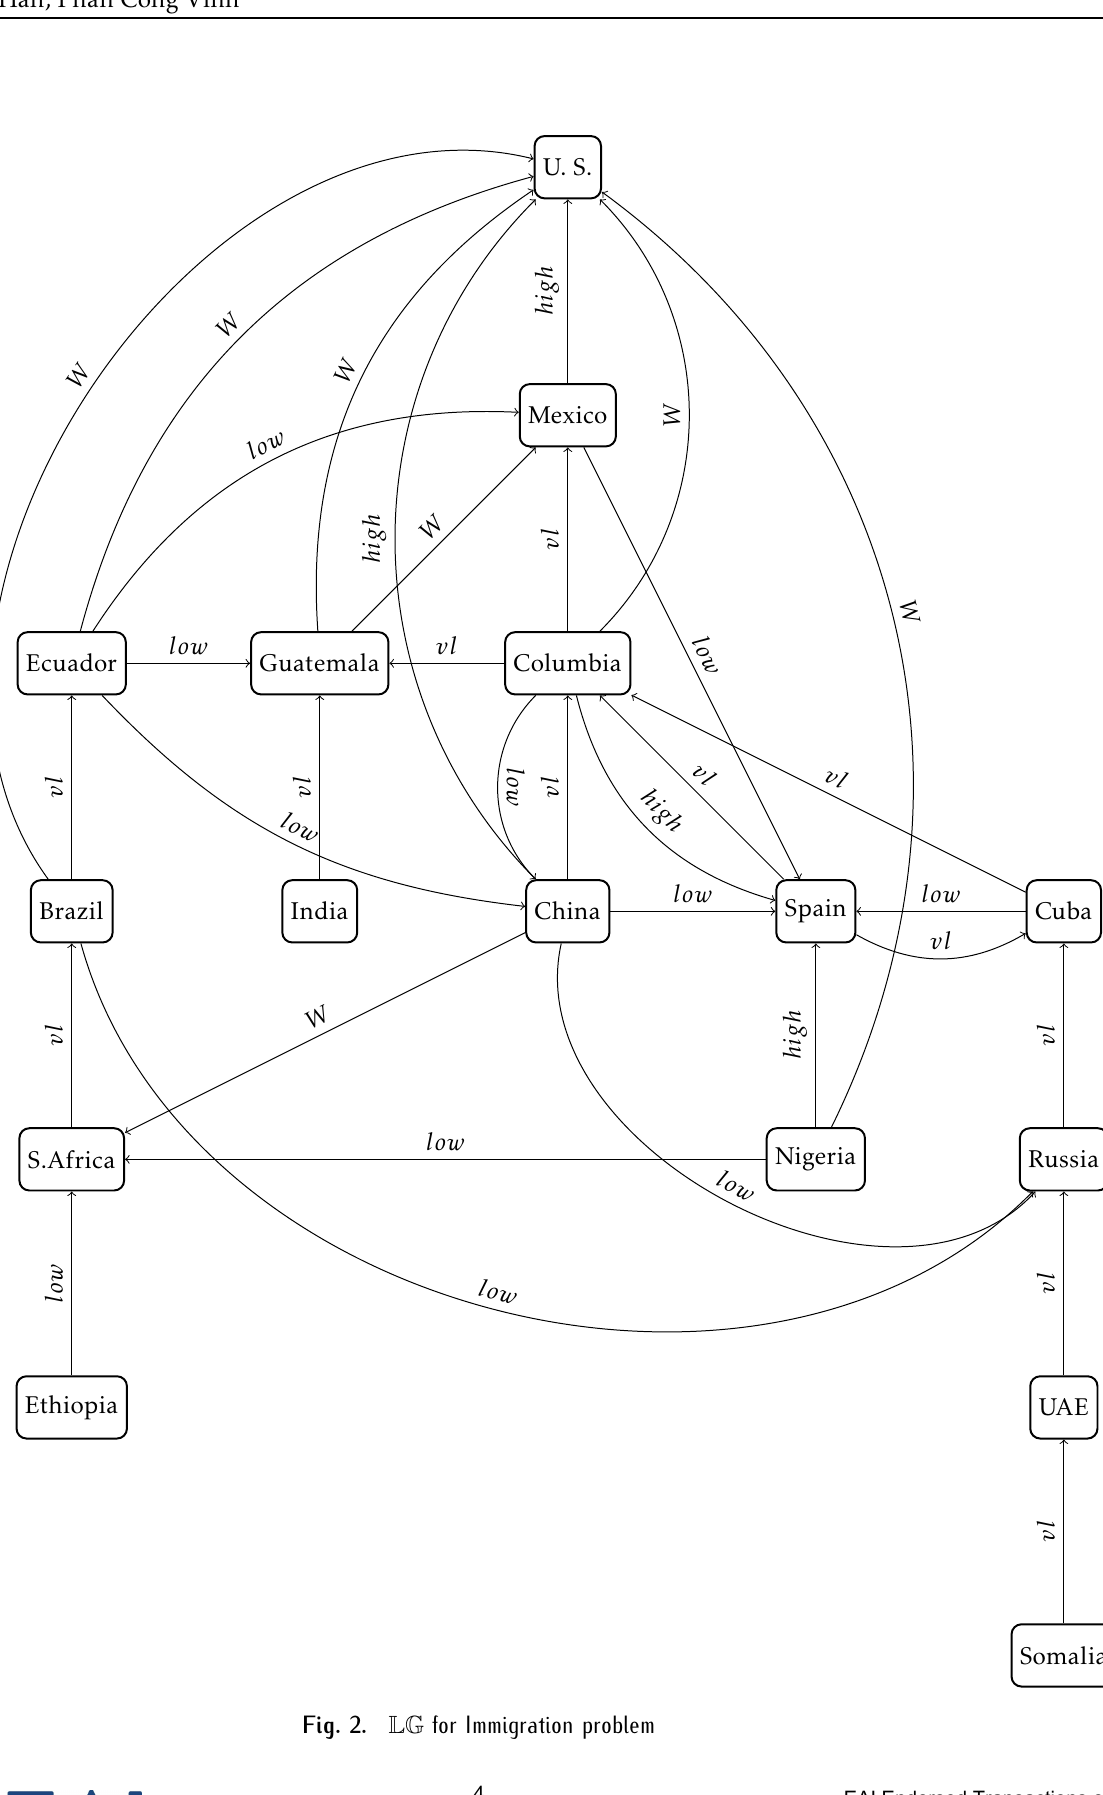
Fig. 2. LG for Immigration